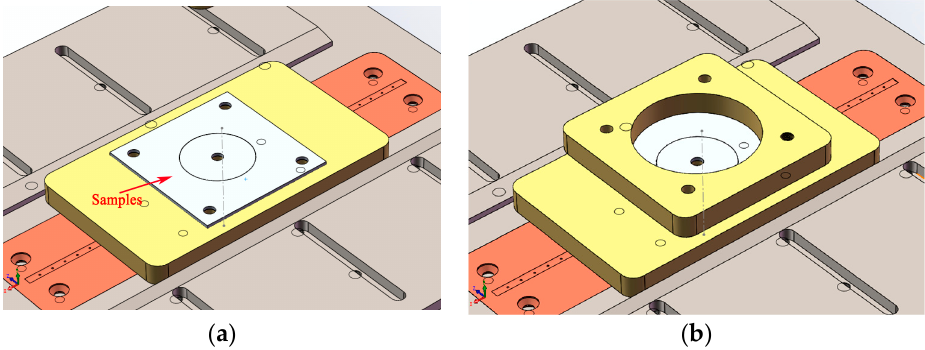
Figure 2. A sketch diagram of the circular-patch welding test instruments. ( a ) Samples ( b ) Test instruments with fastening bolts.